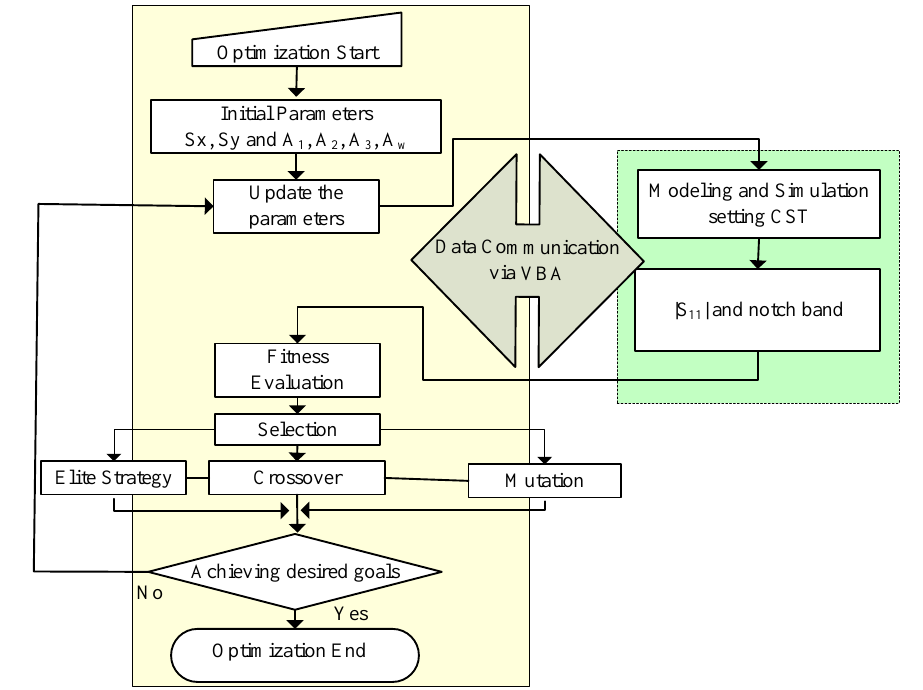
Figure 8. Optimization of the antenna through a GA.